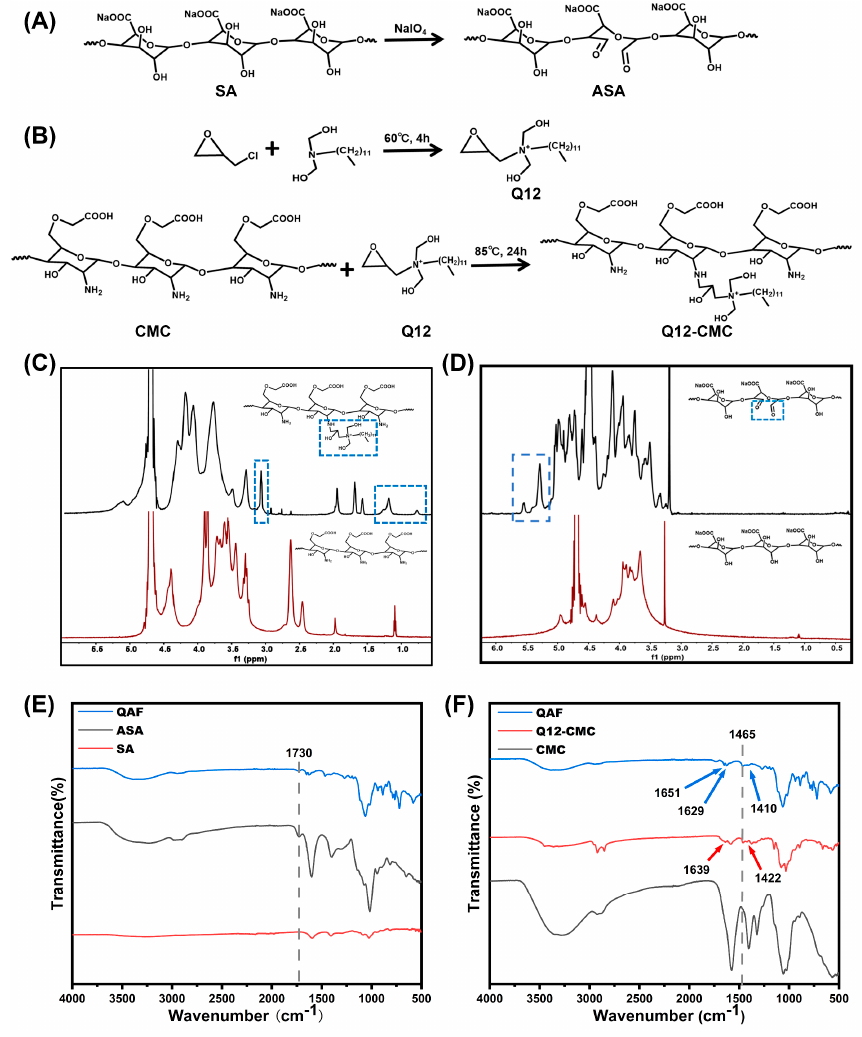
Figure 2. Preparation and structural characterizations of hydrogels. ( A , B ) Route of synthesis of ASA, Q12 and Q12-CMC; ( C ) 1H NMR spectrum of CMC and Q12-CMC (The dotted box indicates the NMR peak corresponding to the dodecyl quaternary ammonium salt); ( D ) 1H NMR spectrum of SA and ASA (The dotted box indicates the NMR peak corresponding to the aldehyde group); ( E , F ) FTIR spectra of SA, ASA, CMC, Q12-CMC and QAF hydrogels.